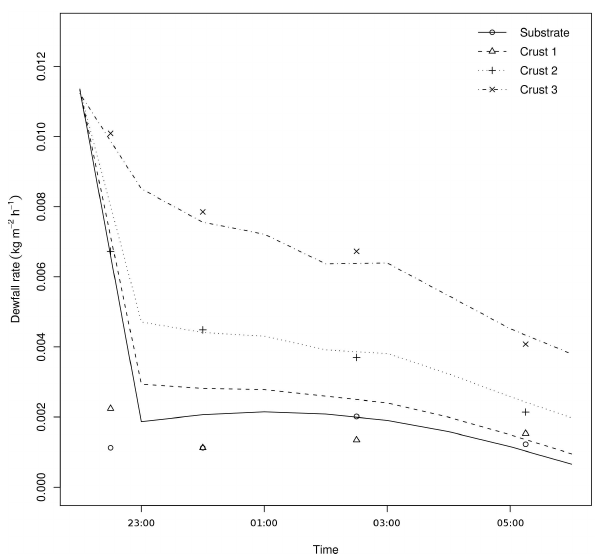
Fig. 3. Dewfall rate over time for the substrate and for the crusts Figure 3 Dewfall rate over time for the substrate and for the crusts 1, 2 and 3. Recording date: 458 1, 2 and 3. Recording date: 17–18 August 2011. Symbols represent 17.-18.08.2011. Symbols represent measured values, lines represent the model response, n=3. 459 measured values; lines represent the model response, n = 3.